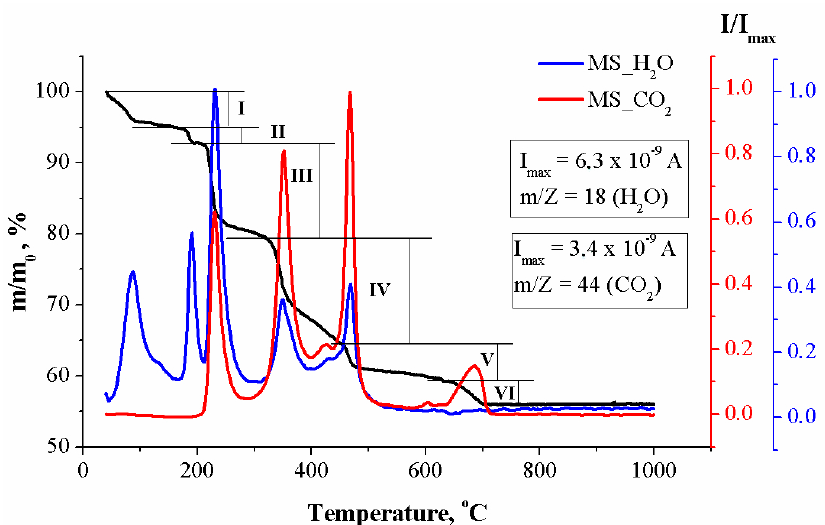
Figure 3. Thermal analysis of the cement-salt stone based on powder mixture of calcium citrate tetrahydrate and sodium dihydrogen phosphate: powder mass versus temperature upon heating ( black curve ), mass spectra for evolving gases with m/Z = 18 (H 2 O) ( blue curve ), and for m/Z = 44 (CO 2 ) ( red curve